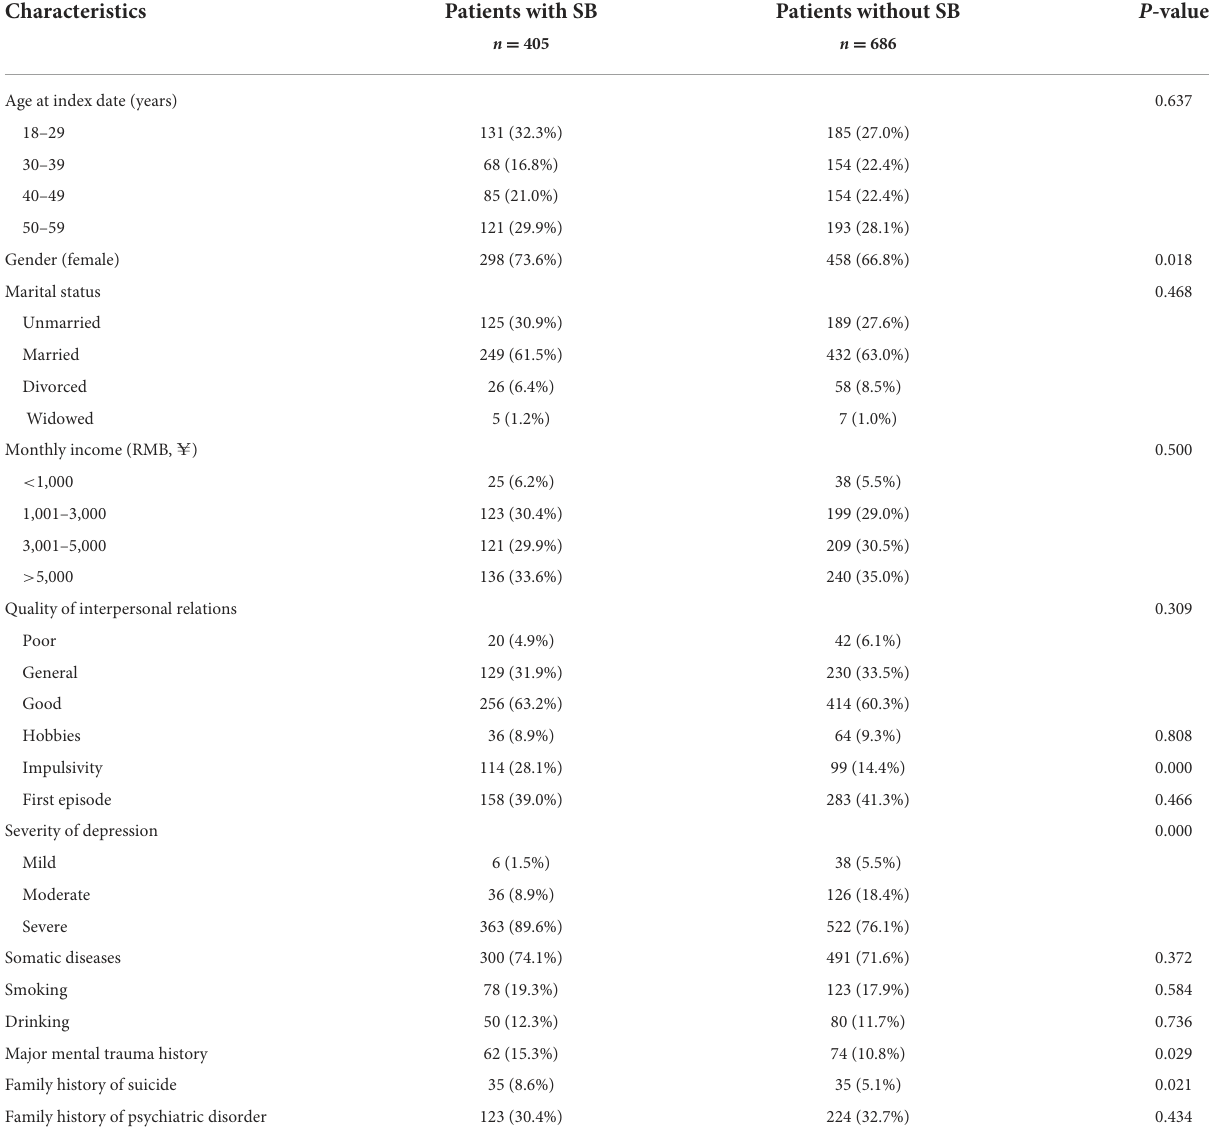
TABLE 1 Characteristics of depression cases with or without suicidal behavior. Characteristics Patients with